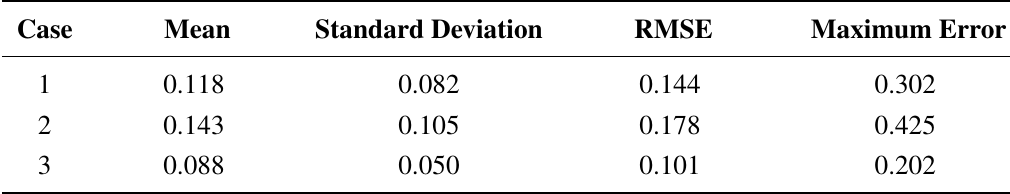
Table 4. Mean, standard deviation, root mean square and maximum of distance error (dimension in meters).